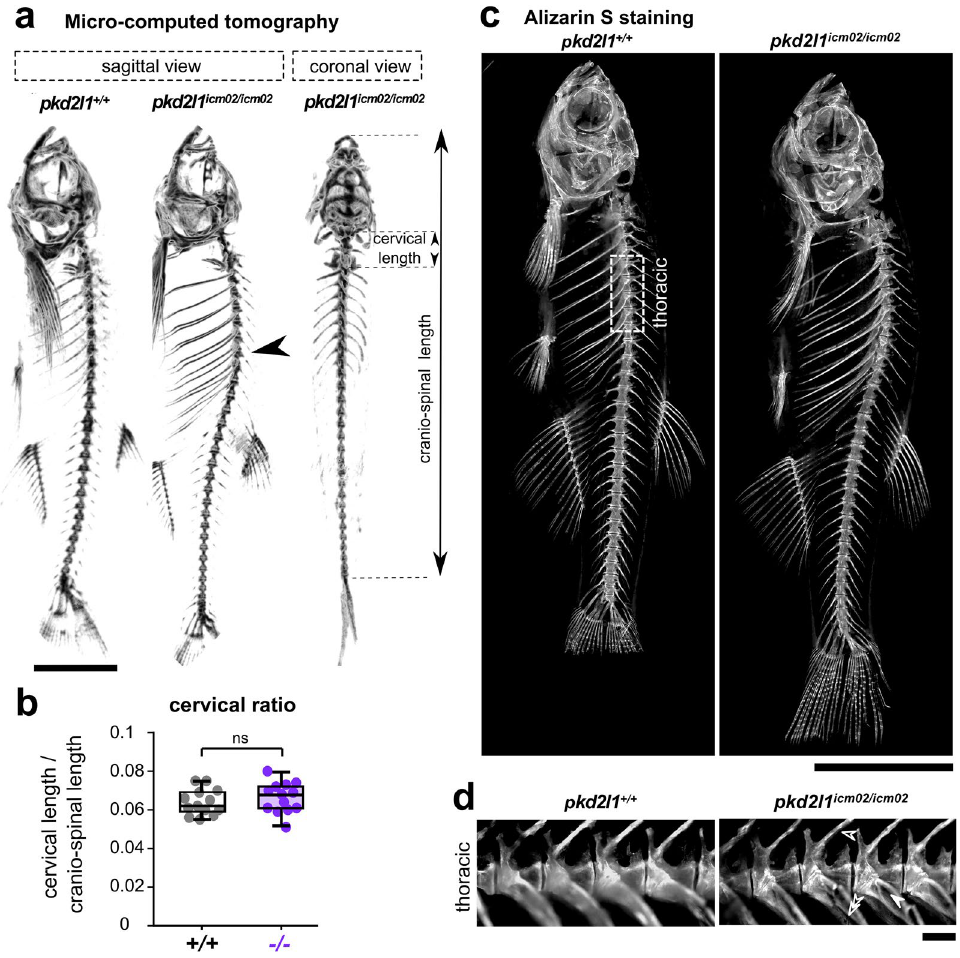
Figure 1. pkd2l1 null mutants develop during adulthood an idiopathic hyper-kyphosis of the thoracic spine. ( a ) 3D micro-computed tomography reconstruction images of a 18 months-old wild-type ( pkd2l1 + / + , left sagittal view) and a pkd2l1 icm02/icm02 mutant sibling (middle, sagittal view; right, frontal view). pkd2l1 icm2/icm02 mutants exhibit a thoracic hyper-kyphosis of the spine (arrowhead) but show no deformity in the coronal plane. Scale bar: 0.5 cm. ( b ) Distribution at 18 months-old of the cervical ratio, defined as the cervical length divided by the cranio-spinal length, in wild-type (grey, + / + , n = 13) and pkd2l1 icm02/icm02 mutants (purple, −/−, n = 13). Each point represents a single animal. Boxplots represent median values ± IQR. ns: p > 0.05, Mann–Whitney test. ( c ) Sagittal views of Alizarin S stained-skeletal preparations of 18 months-old wild-type ( pkd2l1 + / + , left) and a pkd2l1 icm02/icm02 mutant sibling (right). Scale bar: 0.5 cm. ( d ) High-magnification fluorescence images of Alizarin S in the thoracic region of the spine (as defined in ( c ), dotted line rectangle) in a wild-type (left) and a pkd2l1 icm02/icm02 sibling (right). Neural arches (empty arrowhead), hemal arches (double empty arrowhead) and ribs (solid arrowhead) are highlighted for the pkd2l1 icm02/icm02 mutant. Note that in both genotypes, no vertebral dislocation, malformation or fusion are observed. Scale bar: 500